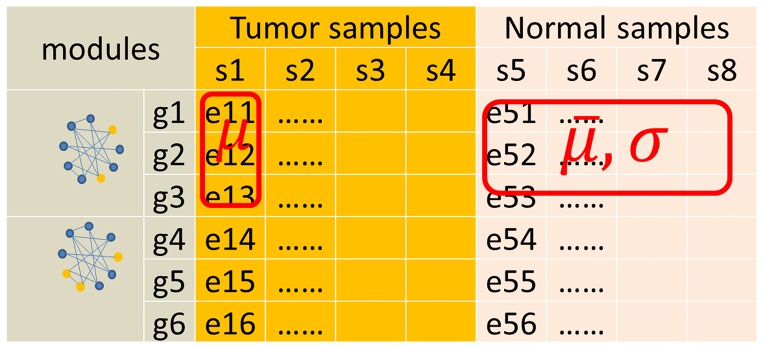
Z-test.Where μ means the average expression value of all genes in module1 for the tumor sample s1; e11 is the expression value of g1 in module1 for s1, so do others;  means the average expression value of all genes for all normal samples; σ is the standard deviation of all normal samples.